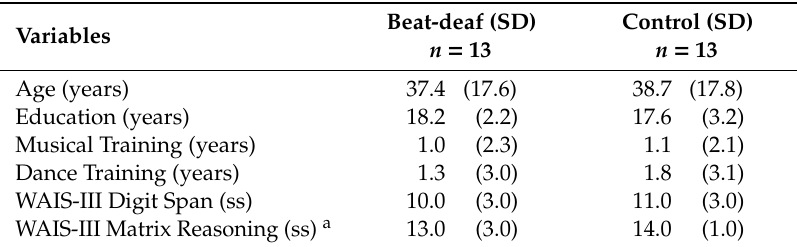
Table 1. Characteristics of the beat-deaf and control groups.